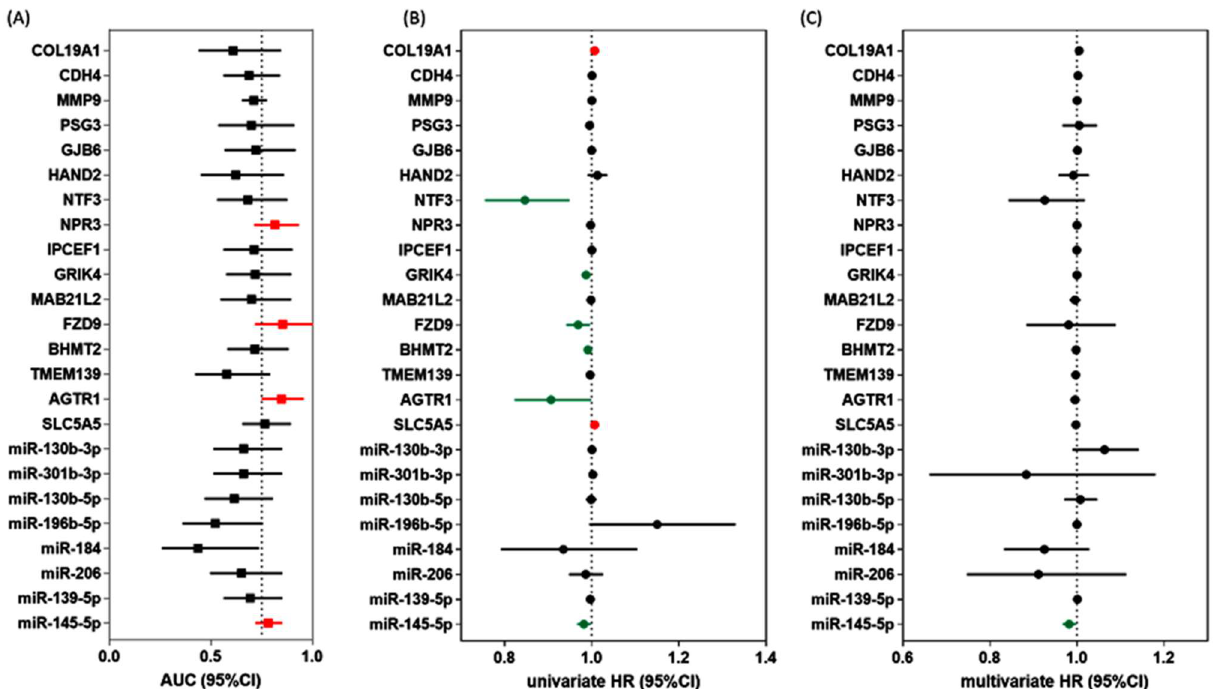
Figure 3. Prognostic and predictive performance of DEG and DEmiR. ( A ) ROC analysis to discrim- inate patients with recurrence from those with non-recurrence. red indicated higher AUC > 0.75. ( B ) Univariate Cox regression analysis for disease-free survival. Red indicated higher risk, green indi- cated lower risk of recurrence, while black indicated no significance. ( C ) Multivariate Cox regression analysis for disease-free survival adjusted by age, sex, race, and BRAF mutation. Red indicated higher risk, green indicated lower risk of recurrence, while black indicated no significance. Abbre-